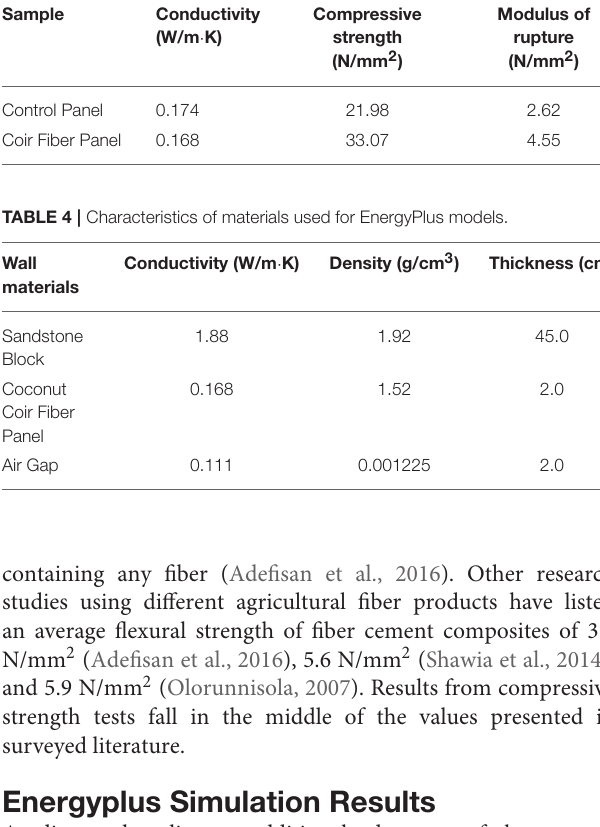
TABLE 3 | Conductivity, compressive strength, and flexural strength values of samples. Sample